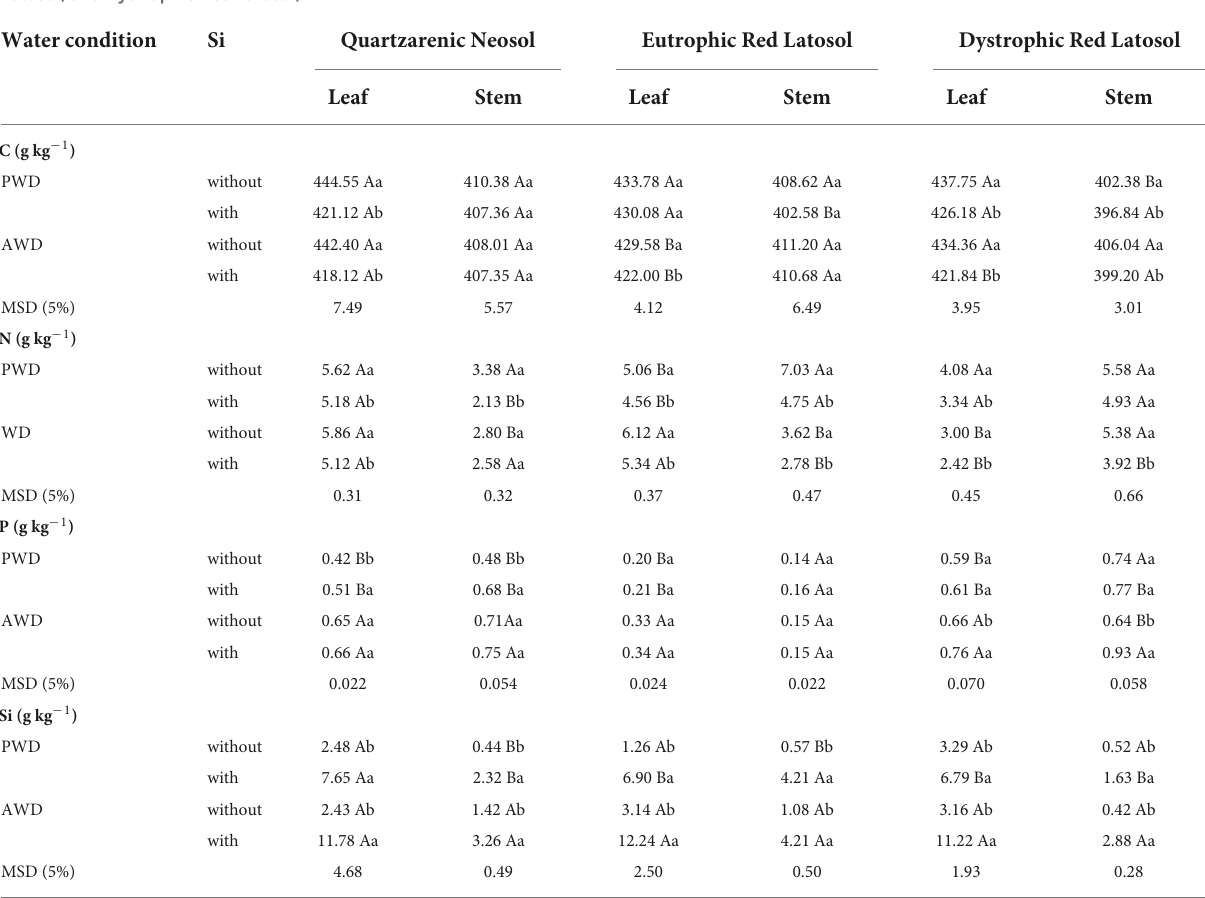
TABLE 2 C, N, P, and Si concentrations in the leaves and stems of sugarcane cultivated with absence (0.0 mM) and presence of fertigated Si (1.8 mM) and two water conditions (without—AWD and with water deficit—PWD) in three tropical soils (Quartzarenic Neosol; Eutroferric Red Latosol; and Dystrophic Red